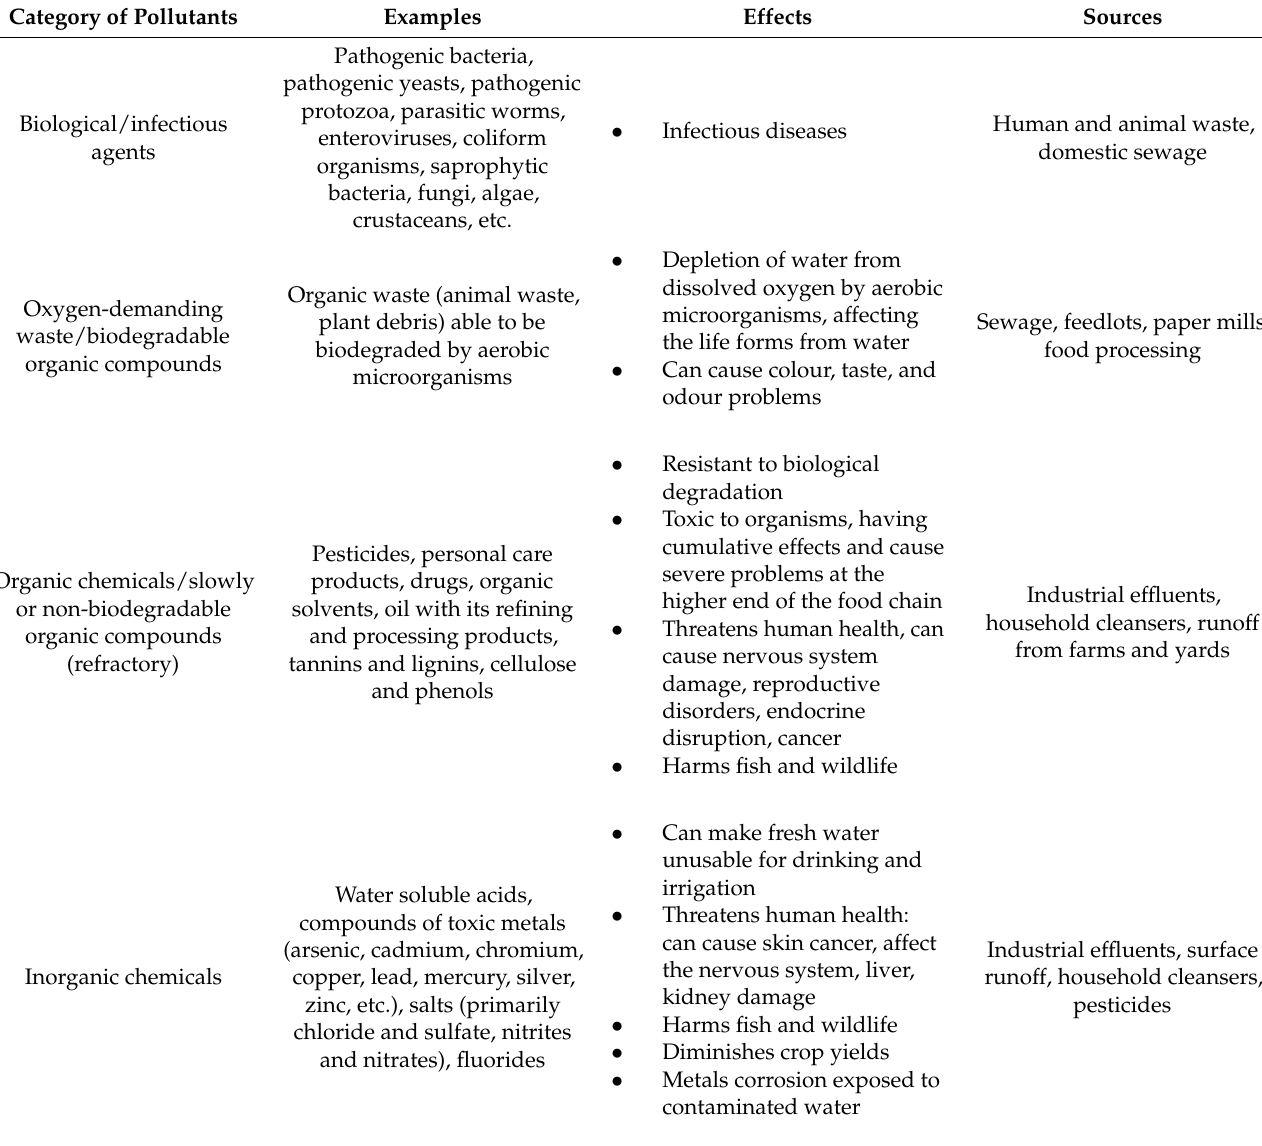
Table 2. Major categories of water pollutants and their